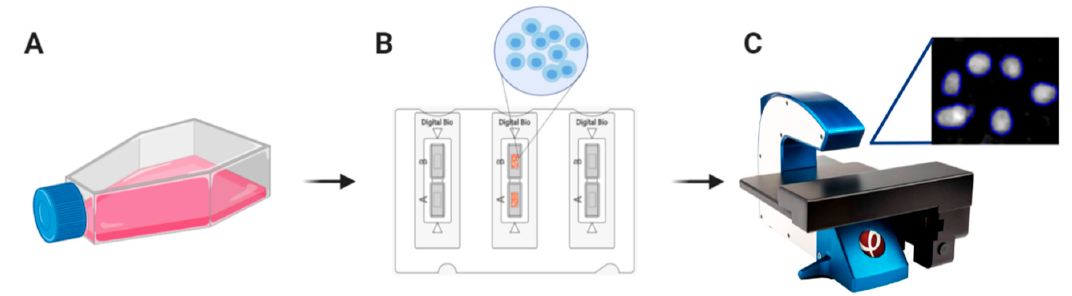
Figure 1. A schematic flow of the experimental system that consisted of the cultured cells ( A ), the detached cells in the cell counting chamber slides ( B ) and the HoloMonitor TM M4 analysis set-up ( C